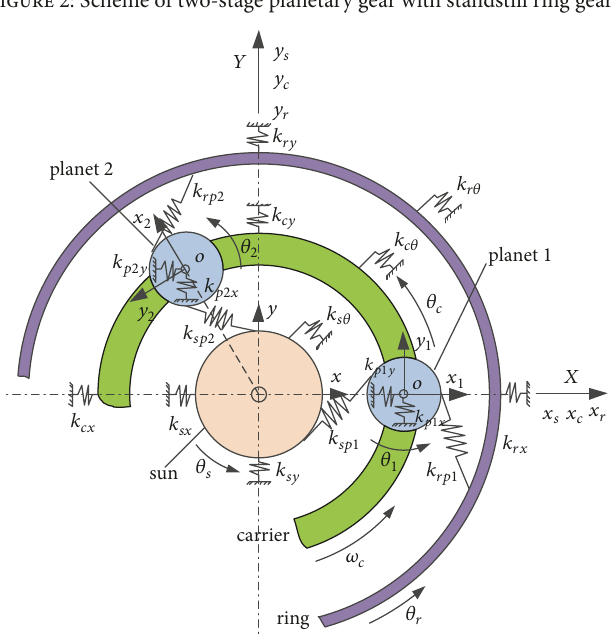
Figure 3: Lumped-parameter planetary gear model and system